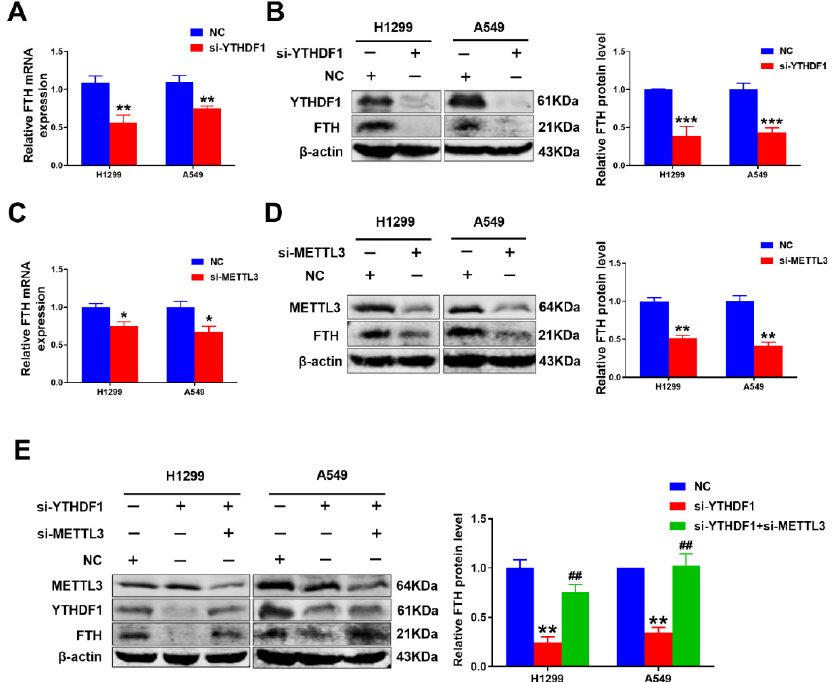
Figure 4. YTHDF1 can positively regulate FTH expression in an m 6 A-dependent manner. ( A , B ) Relative mRNA level and protein level were measured by qRT-PCR and Western blot of FTH in YTHDF1 knockdown H1299 and A549 cells. ( C , D ) The relative mRNA expression and protein level were determined by qRT-PCR and Western blot of FTH after METTL3 knockdown in H1299 and A549 cells. ( E ) The protein level of FTH revealed by Western blot in YTHDF1 knockdown lung cancer cells with METTL3 depression, compared with negative control lung cancer cells. * p < 0.05; ** p < 0.01; *** p < 0.001; and ## p <